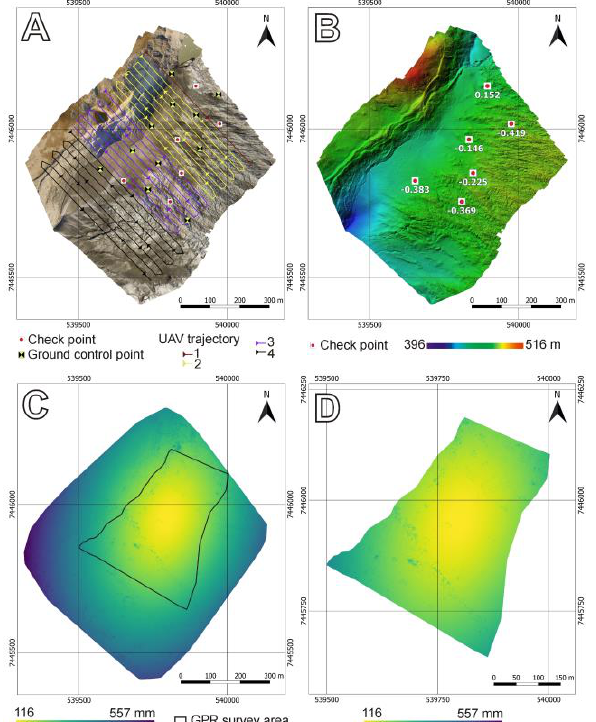
Figure 3. Digital elevation model with vertical errors of checkpoints (A), orthomosaic showing UAV flight plans and directions, and locations of GCPs and checkpoints (B), DEM